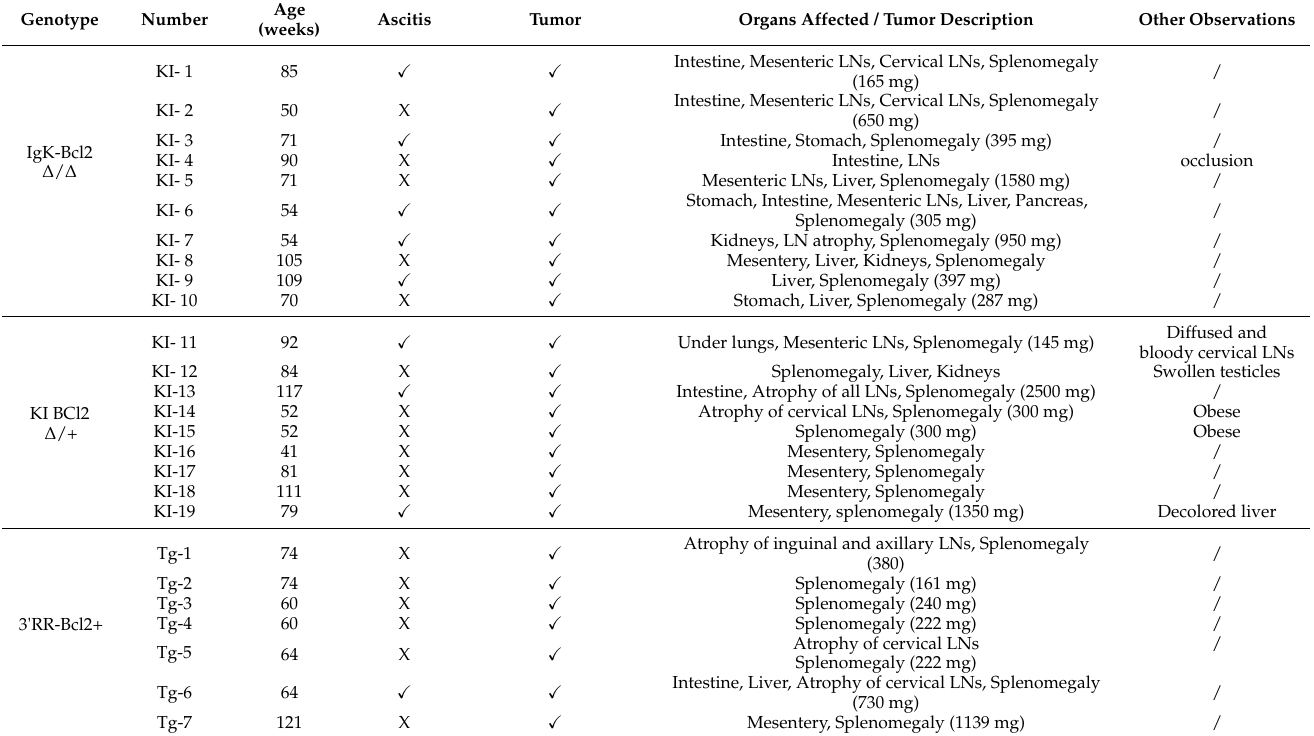
Table 1. Description of tumors: Table describing the mice that developed tumors in both BCL2 models. This cohort comprised 19 Ig κ -BCL2 (total), and 8 3 (cid:48) RR-BCL2 mice were allowed to grow older, and these tumors were monitored for tumor development over time. For each mouse, the age at which they developed the tumor (or pre-tumoral symptoms), along with a detailed description of the location and the phenotype of each tumor, is listed. Organs Affected / Tumor Description Other